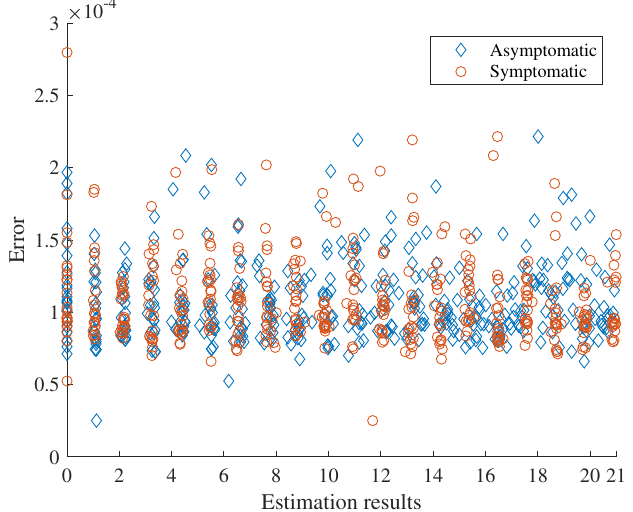
Figure A2. Errors were plotted with respect to the optimization results. The minimum point for asymptomatic case is one, whereas the minimum point for the symptomatic cases is